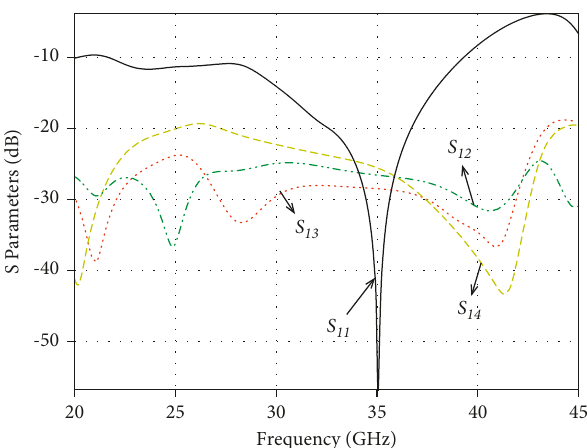
Figure 8: Simulated return loss and transmission parameters of the proposed MIMO configuration.